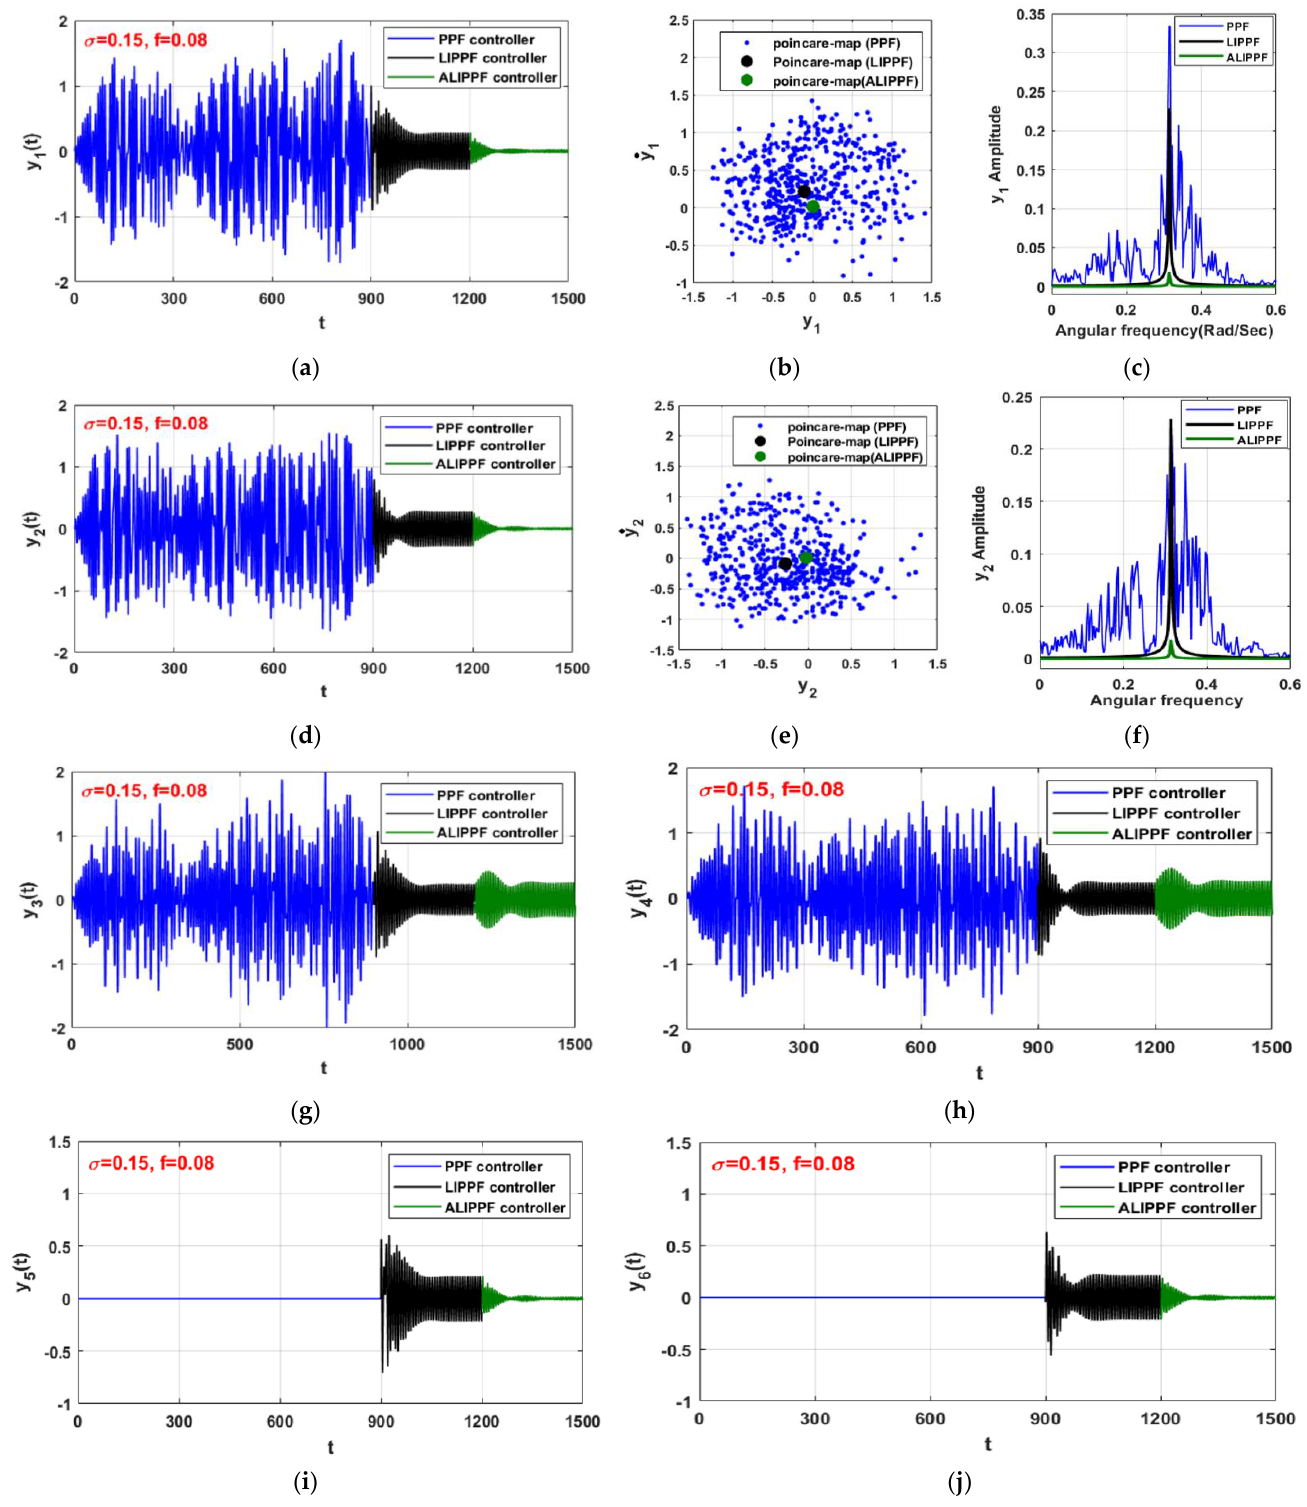
Figure 15. Rotor electro-magnetic suspension time response, Poincare map, and the frequency spectrum with the PPF-controller, LIPPF-controller, and ALIPPF-controller at σ = 0.15 and f = 0.08: ( a , d ) the temporal oscillations of the rotor system in X 1 and X 2 directions, ( b , e ) the corresponding Poincare map of the rotor system, ( c , f ) the corresponding frequency spectrum of the rotor, and ( g – j ) the temporal oscillations of the controllers.